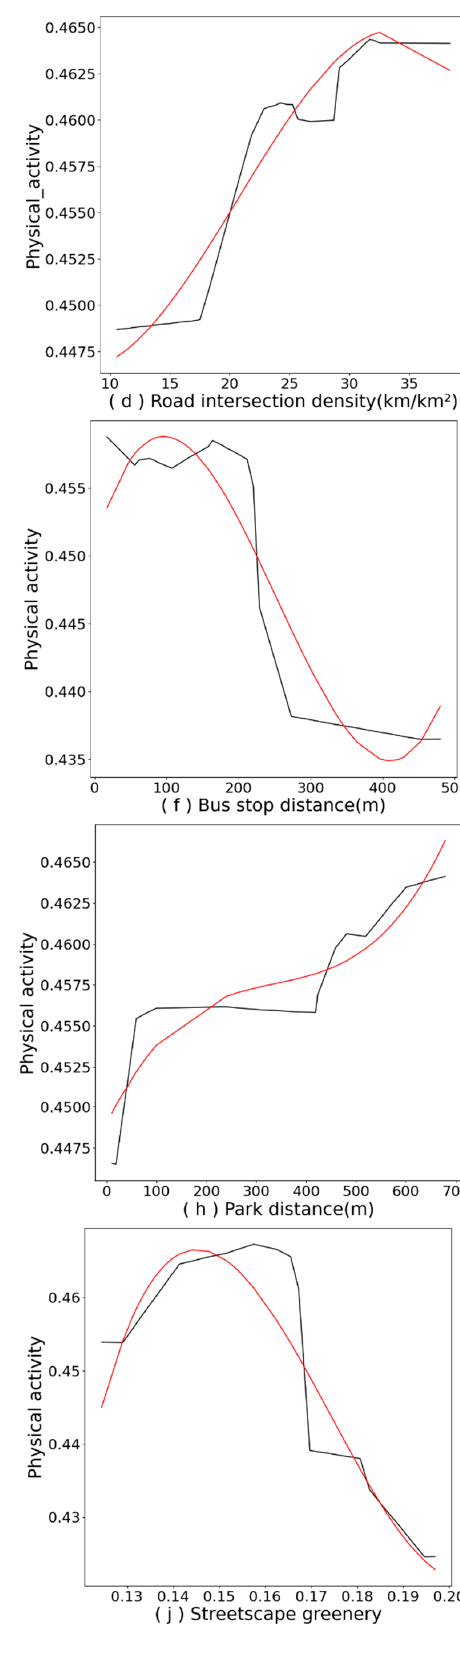
Figure 4. The nonlinear effect of built environment characteristics on physical